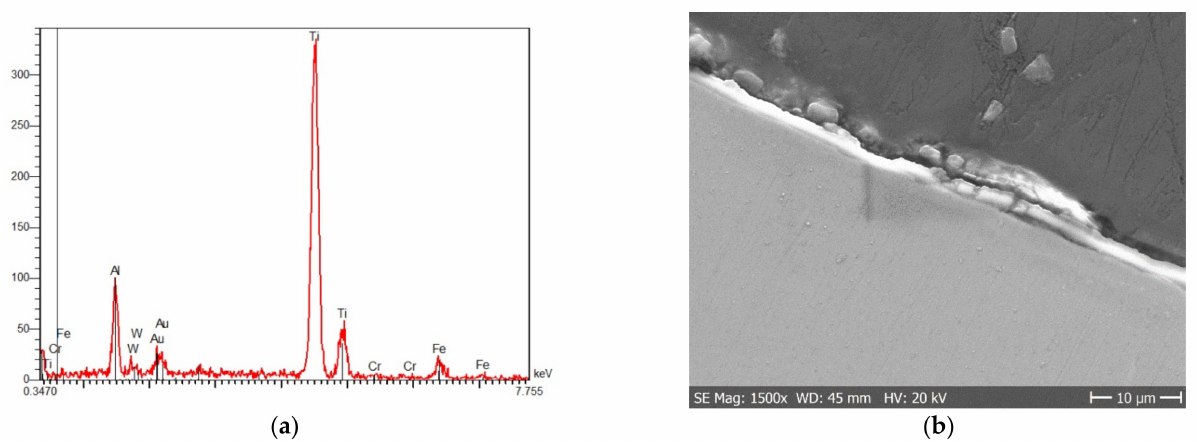
Figure 6. SEM results of the N-H-PN-PVD test sample: ( a ) chemical composition and ( b ) SEM